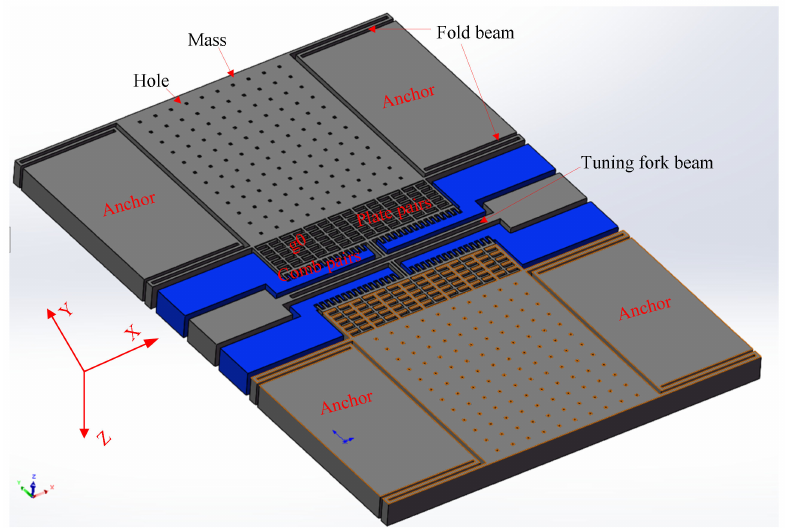
Figure 1. Structural diagram of an accelerometer.